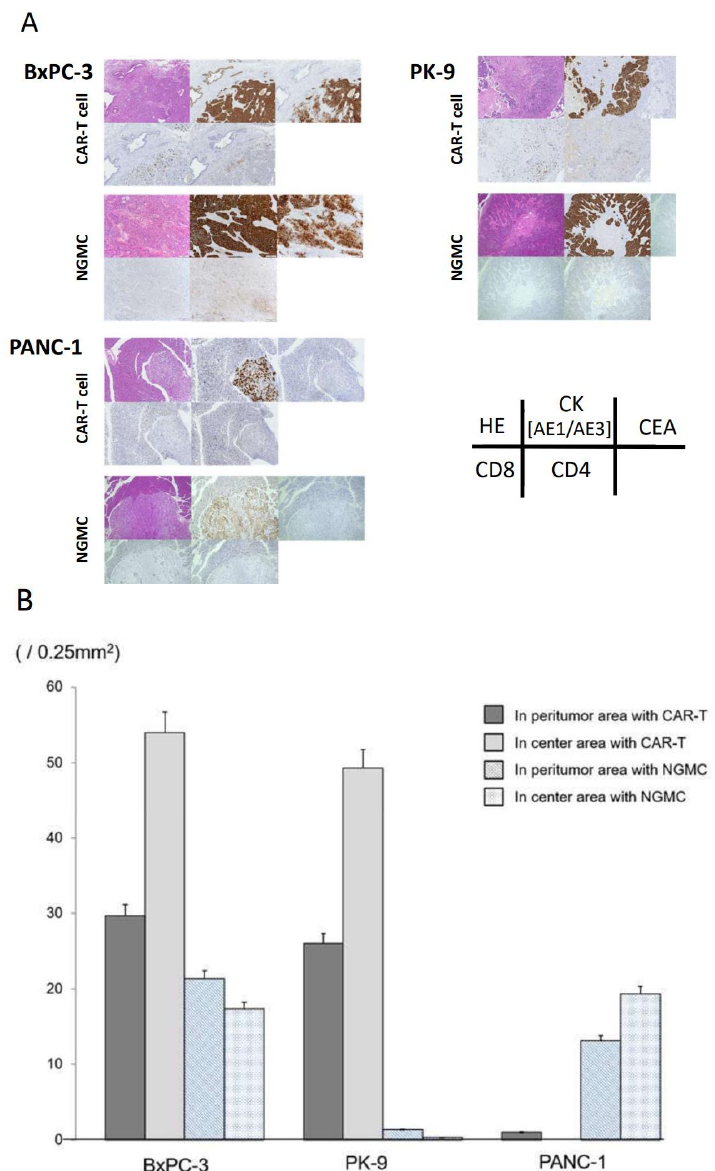
Figure 6. Histopathological examination of specimens collected from mice. ( A ) Tissues from ortho- topic mouse models treated with anti-CEA-CAR-T or non-modified T cells on day 21 were stained with hematoxylin and eosin and analyzed for CD4, CD8, CK, and CEA expression by antibody staining. ( B ) Counts of CD8 + T cells infiltrating into the center and peritumor area within the range of 0.25 mm 2 /field.